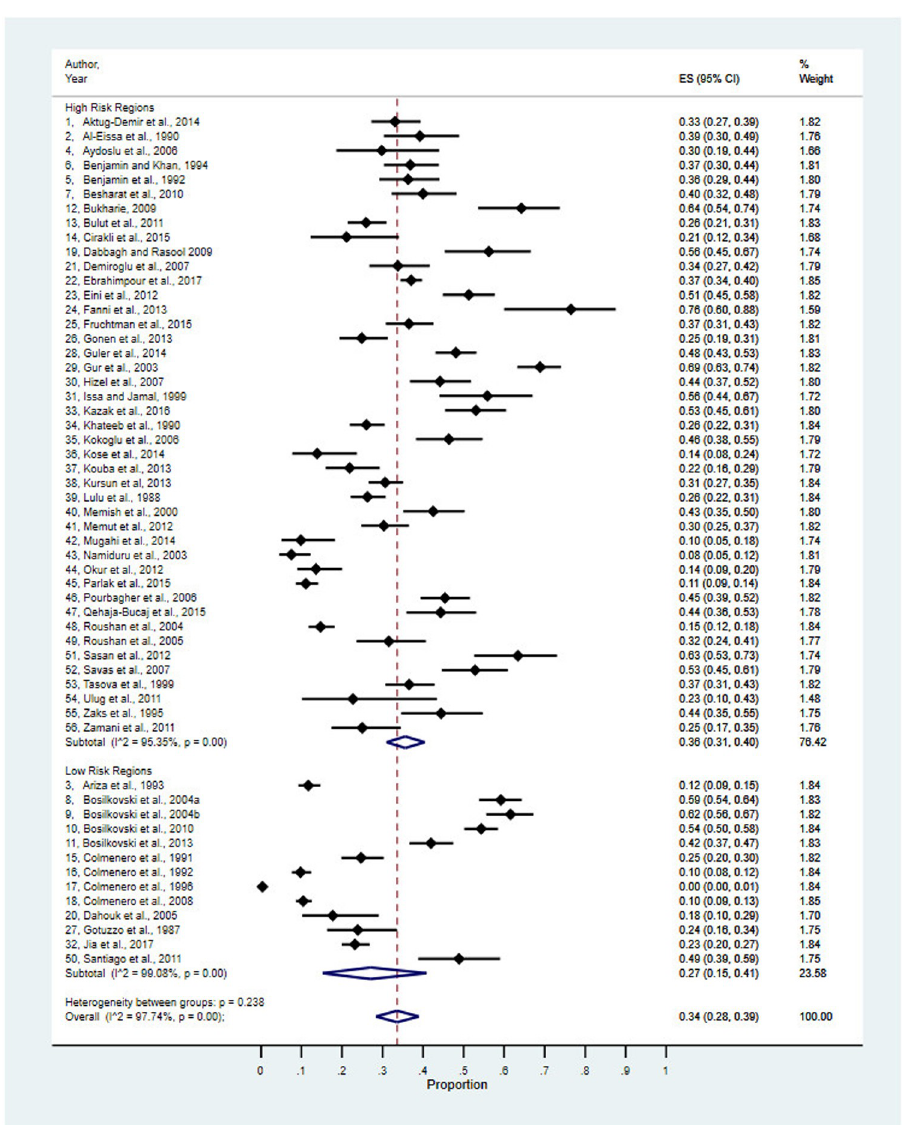
Fig 3. Prevalence estimates stratified by risk